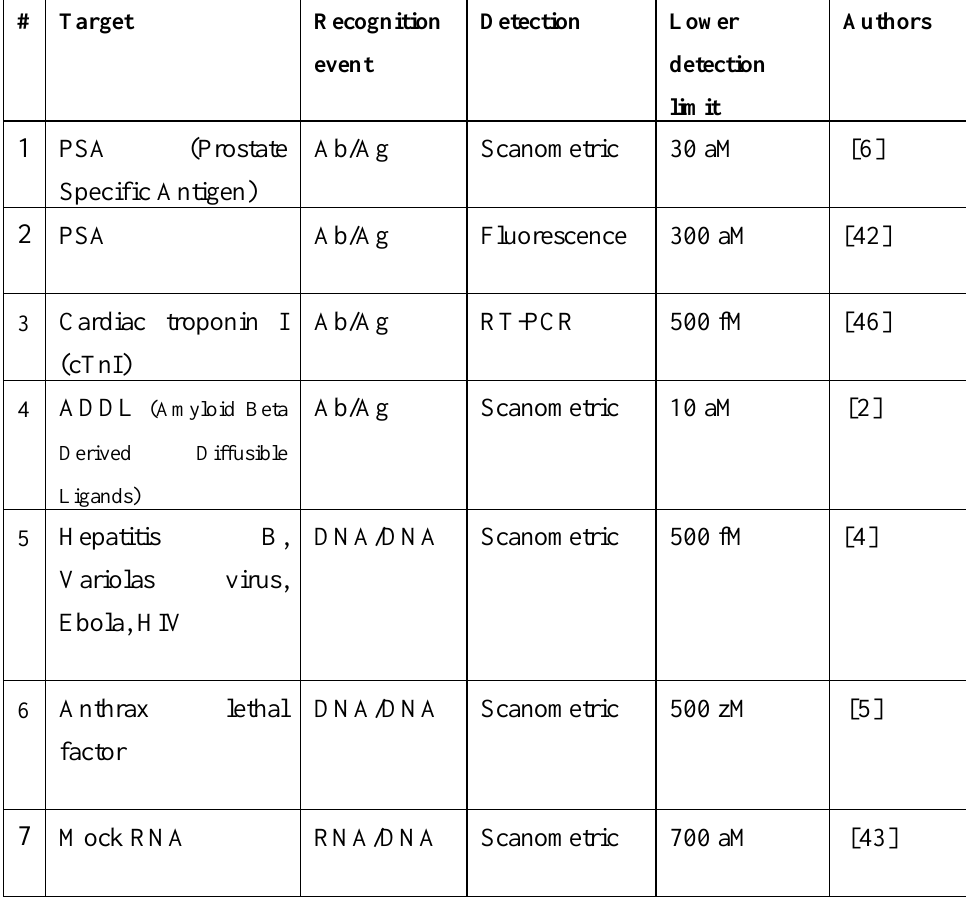
Table 5. Summary of biological target detected through a Bio–bar code